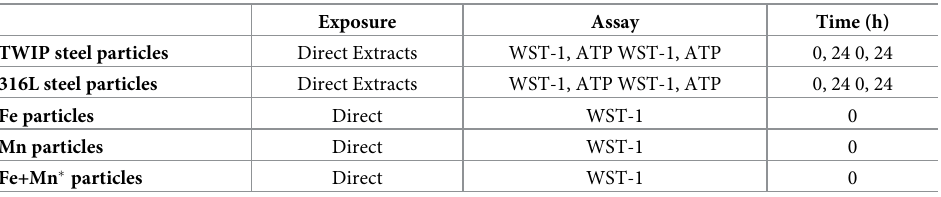
Table 1. Materials used, test type, and cell viability